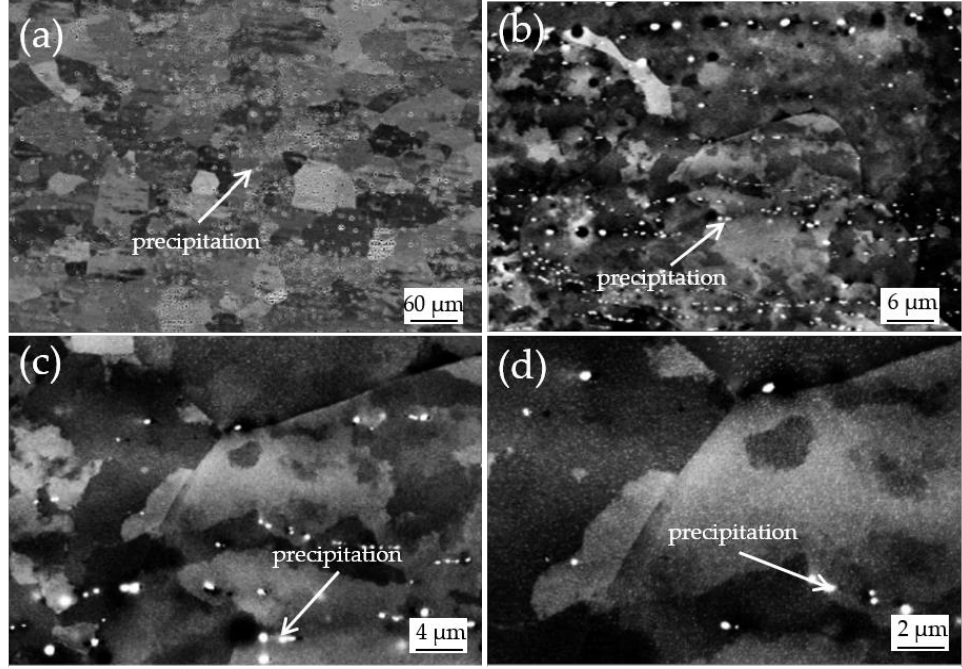
Figure 10. Precipitation distribution of Al-0.5%Cu alloy in SH annealing at 250 °C for 10 min in different multiples: ( a ) 500 × ; ( b ) 5000 × ; ( c ) 7000 × ; ( d ) 10,000 × .